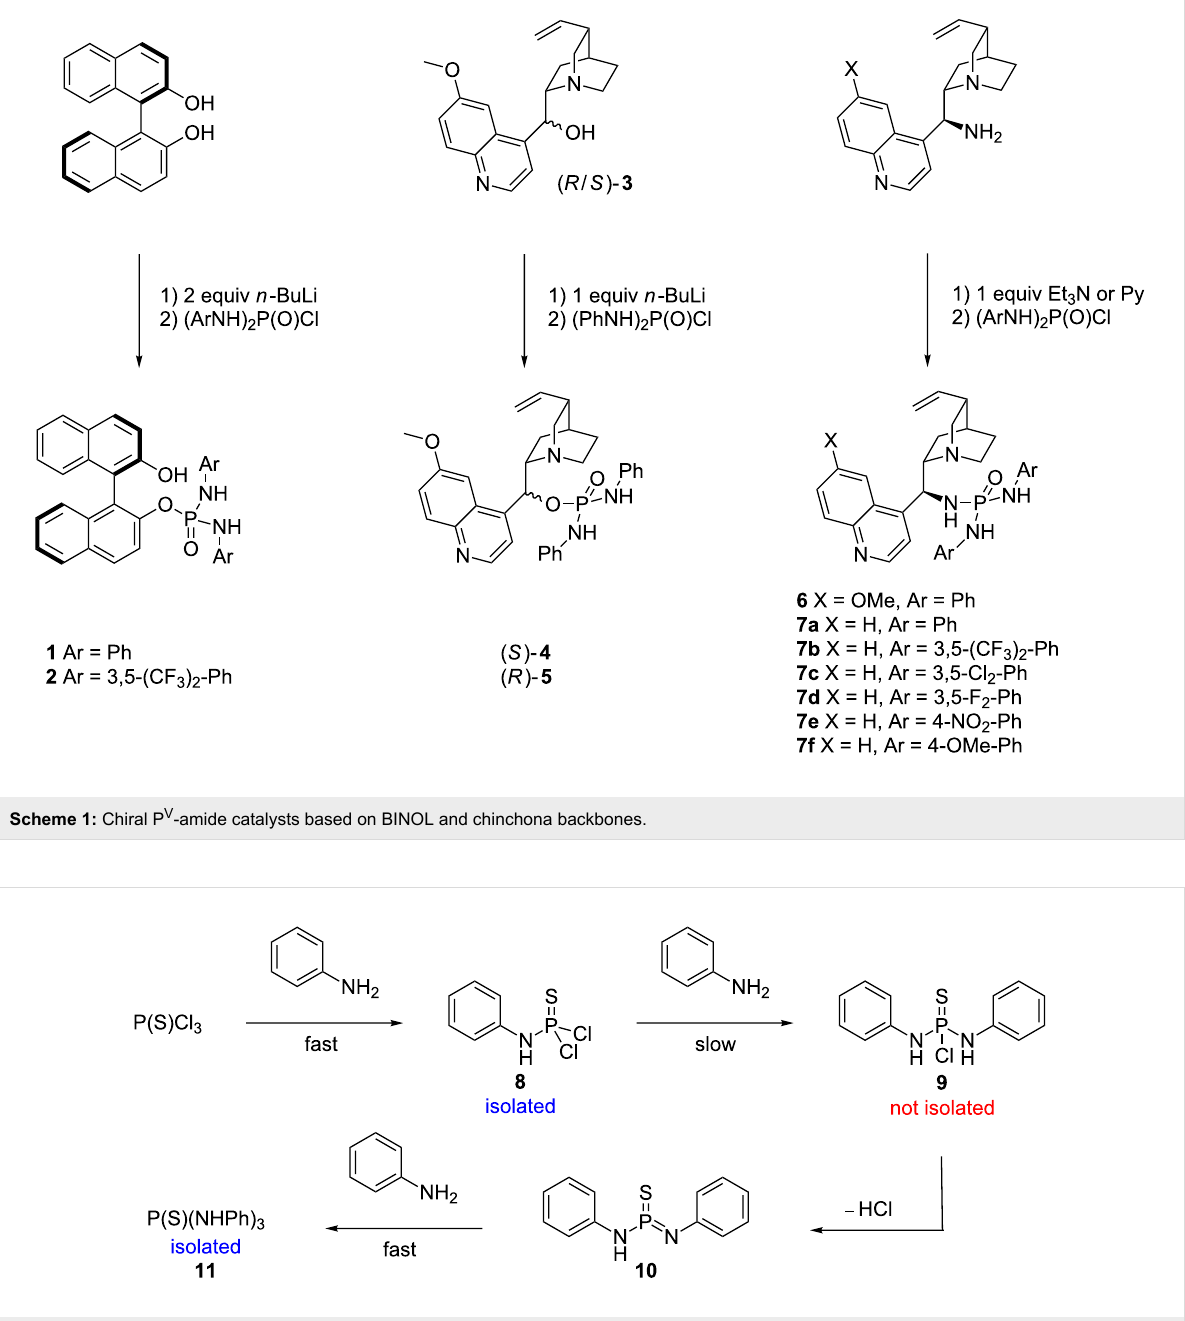
dependent NMR (Supporting Information File 1). The cause